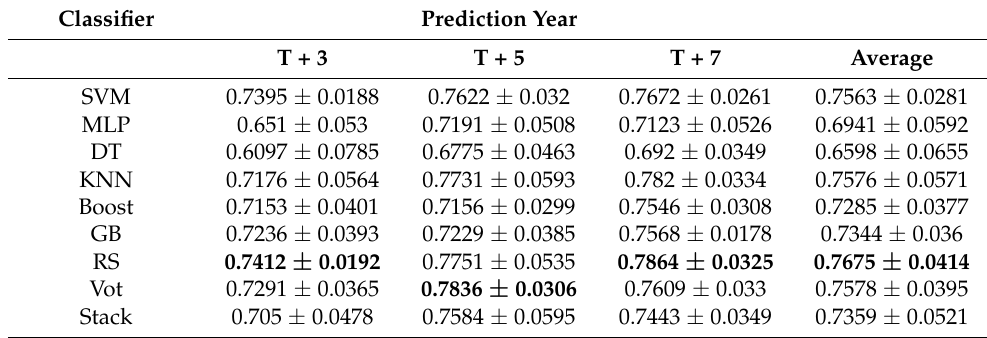
Table 5. Area Under Curve (AUC) for Each Classifier with Three Different Prediction Years.